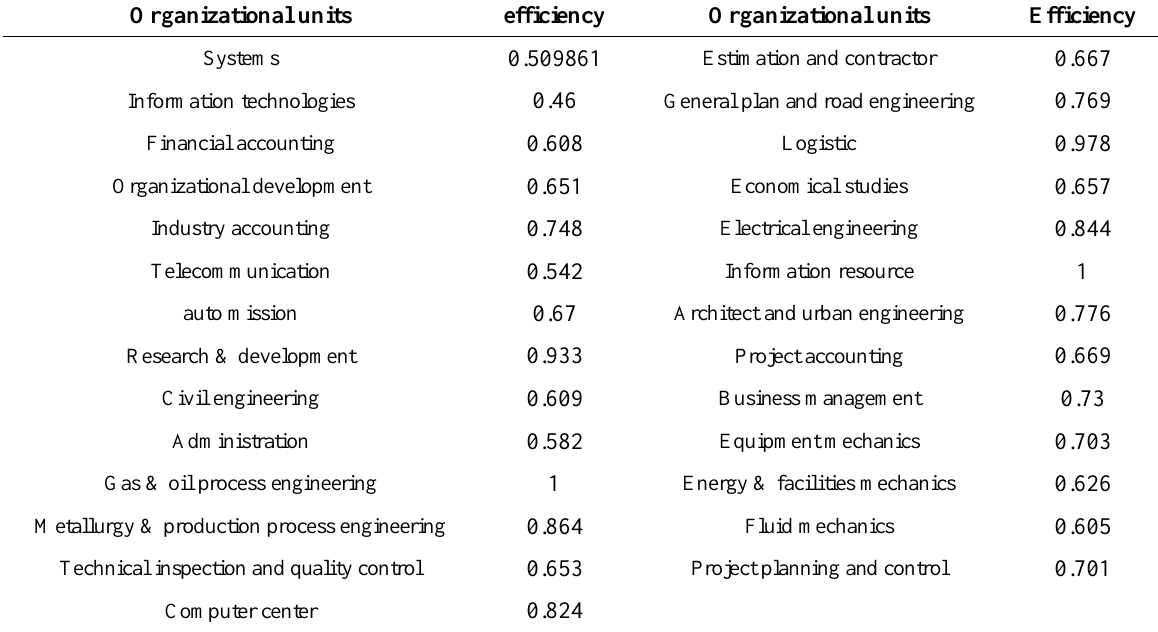
Table 3. Efficiency of units